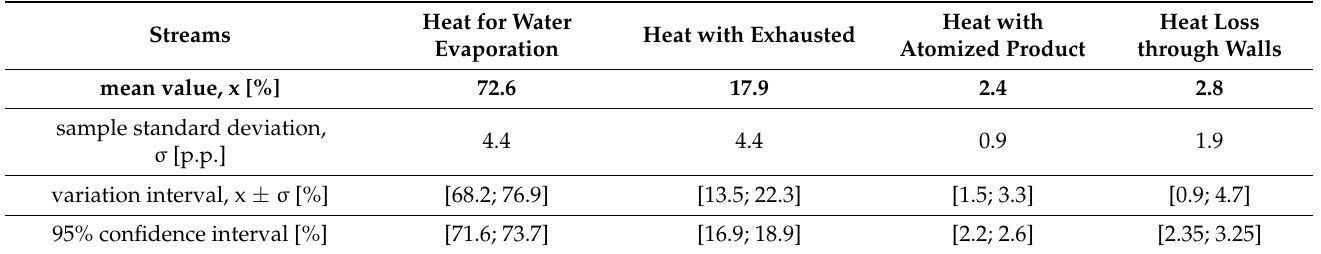
Table 5. Results of the energy balance analyses performed, on direct measurements, on 67 spray drier